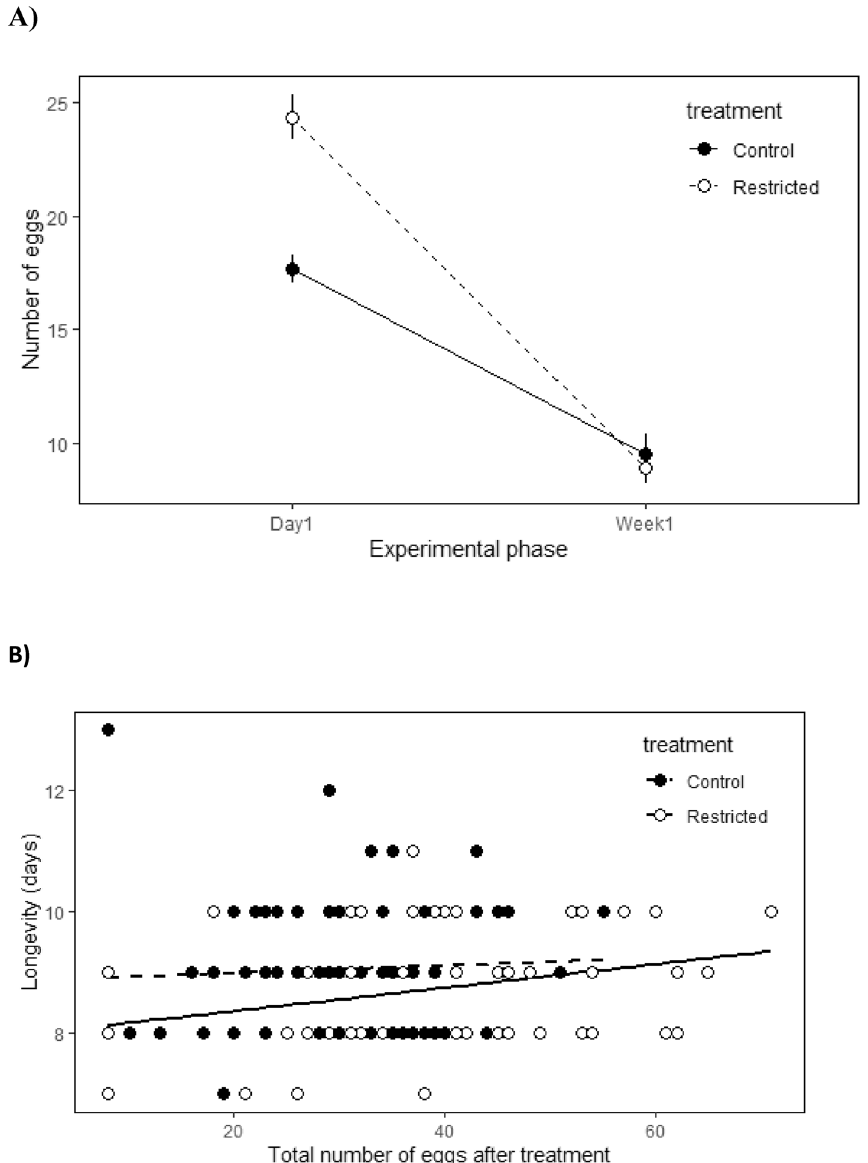
Figure 4. Long-term experiment: relationship between resource availability and reproductive output after the treatment for the two experimental groups (restricted and control). ( A ) Number of eggs laid on the day after the treatment (1-day vial) and the subsequent days (1-week vial). Error bars reflect standard errors around the mean. ( B ) Relationship between the total number of eggs produced after the treatment and longevity. Note that the reproductive investment during the treatment was not estimated in this experiment (see main